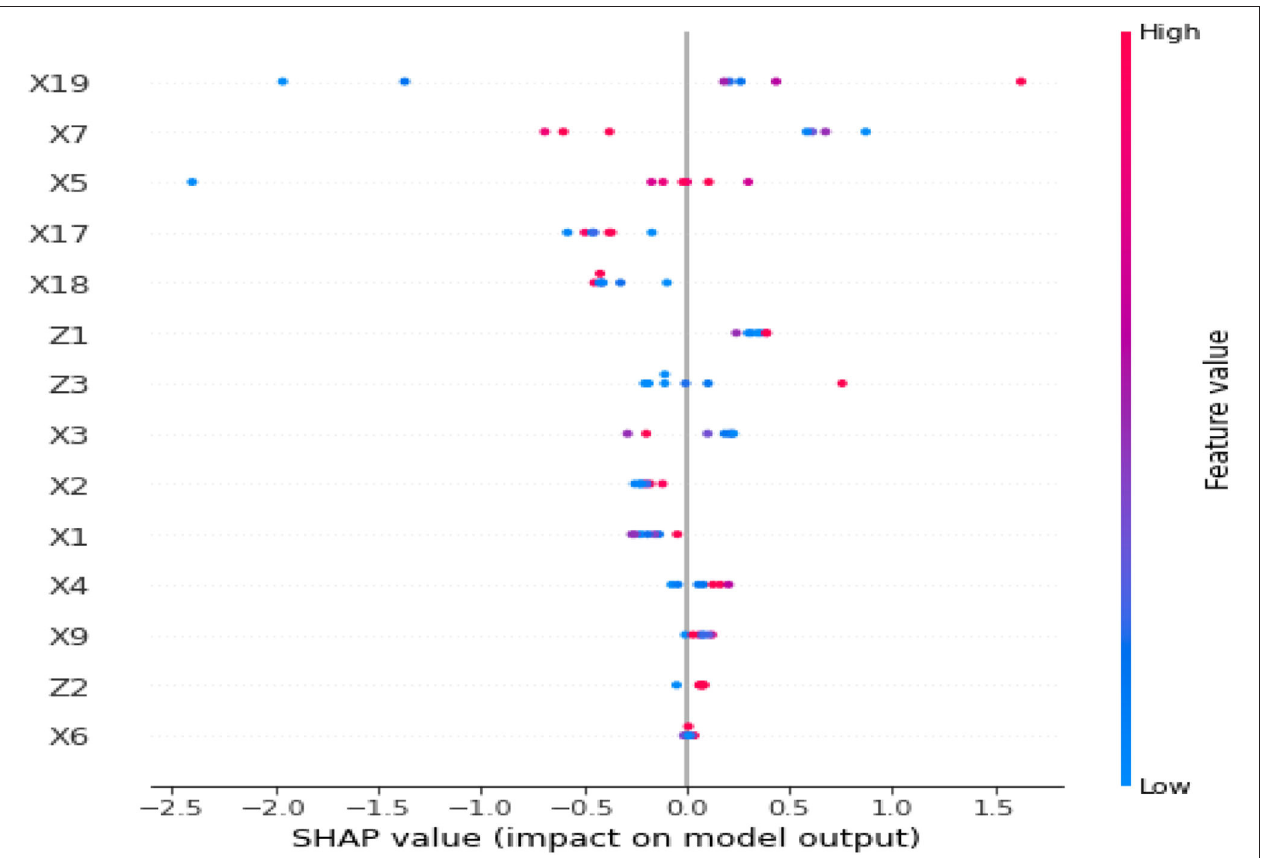
FIGURE 3 | SHapley Additive exPlanations (SHAP) value for UHC prediction in all the